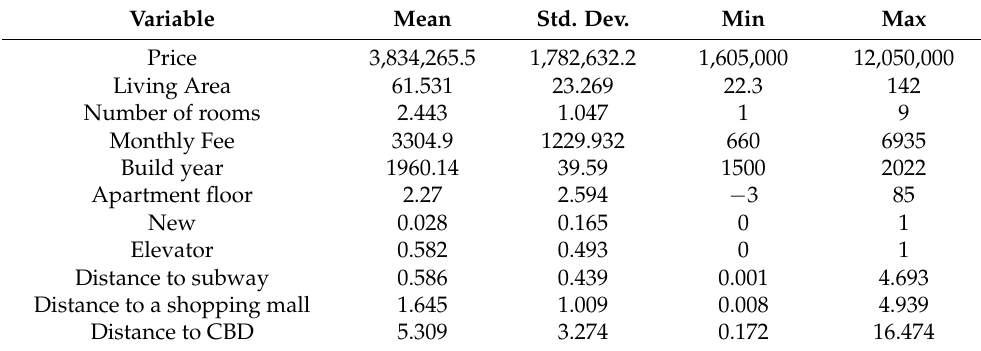
Table 3. Descriptive statistics of the transactions.